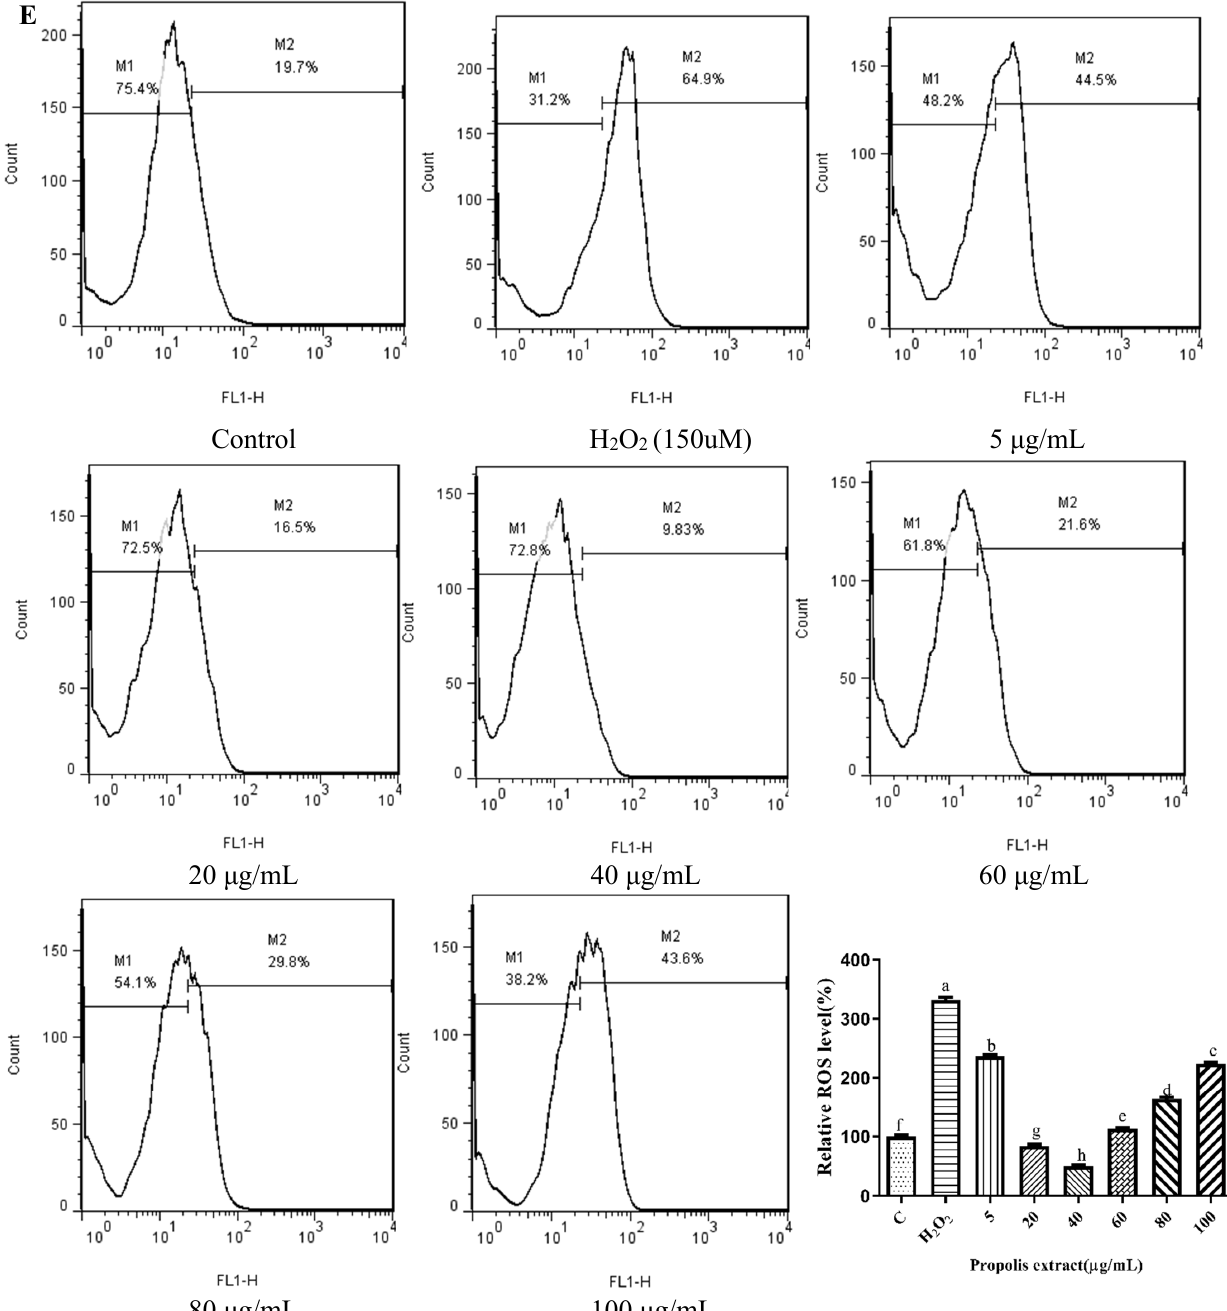
Figure 3. ROS levels induced by individual flavonoids (chrysin, pinocembrin, galangin, and pinobanksin) and propolis extract in 150 μ M H 2 O 2 -induced H9c2 cells. H9c2 cells were stimulated with different concentrations of phytochemicals (chrysin, pinocembrin, galangin, pinobanksin, and propolis extract) for 12 h and then treated with 150 μ M H 2 O 2 for 1 h; finally, ROS levels were detected using a flow-cytometry assay. ( A ) ROS levels in chrysin-induced H9c2 cells. ( B ) ROS levels in pinocembrin-induced H9c2 cells. ( C ) ROS levels in galangin-induced H9c2 cells. ( D ) ROS levels in pinobanksin-induced H9c2 cells. ( E ) ROS levels in propolis-extract-induced H9c2 cells. Values are expressed as the mean ± SEM ( n = 3). Values with different letters (a, b, c, d, e) in the figure showed significant differences at p < 0.05.